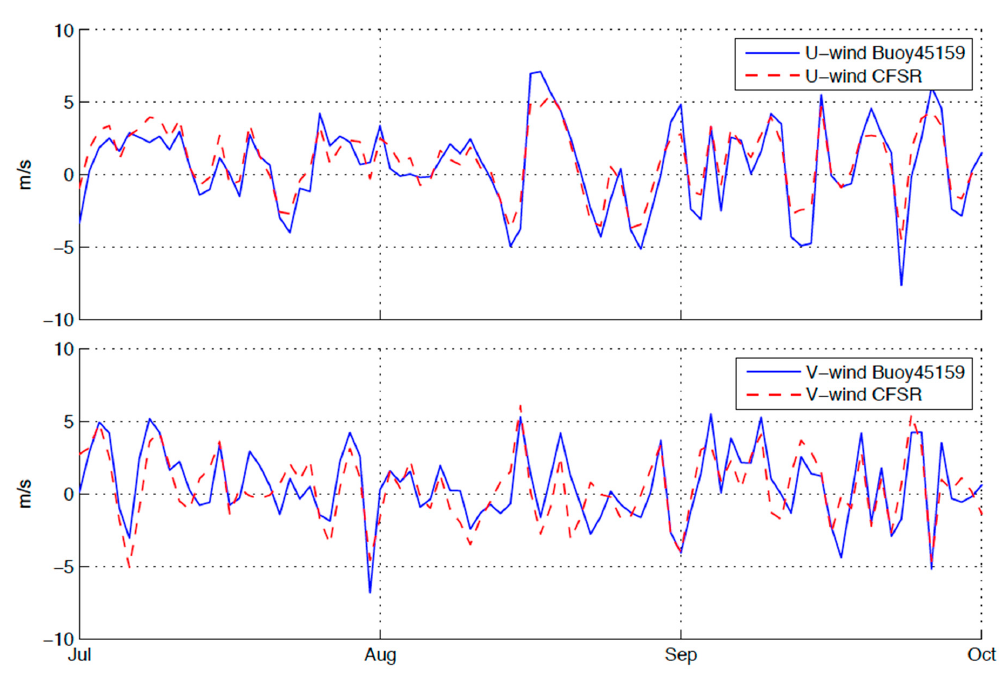
Figure 5. Upper panel: comparison of the daily averaged wind speeds from NDBC Buoy 45159 and from the Climate Forecast System Reanalysis (CFSR) reanalysis wind speed at the buoy location. Lower panel: wind rose plots based on the same dataset. The length of each “spoke” around the circle represents the frequency (%) with which the wind blows from that direction. Each concentric circle represents a different frequency, increasing from zero at the center to higher frequencies at the outer circles. All wind roses use 16 cardinal directions (e.g., north (N), north-northeast (NNE), northeast (NE), etc.). Wind speeds are presented in 2-m/s bins using the color bar at the lower right. Wind and currents in the nearshore of northern Lake Ontario are well correlated. For example, a comparison of the longshore wind component derived from buoy measurements and the alongshore currents measured by the ADCP yielded a correlation coefficient of 0.61, even though the buoy and the ADCP were not at exactly the same locations (the buoy is located farther offshore; Figure 3). In addition, the longshore wind component obtained from the CFSR data and alongshore currents simulated by FVCOM were well correlated ( r = 0.76); here, both results are taken at the ADCP location. These results suggest that wind patterns significantly affect flow conditions in this region, and that hydrodynamic models will capture realistic flow conditions if quality meteorological forcing is used to drive the model. This conclusion is confirmed by a comparison of flow conditions measured by the ADCP and simulated by FVCOM (Figure 6). Model-simulated current conditions agree well with ADCP measurements for both alongshore and cross-shore flow components (Figure 6). The